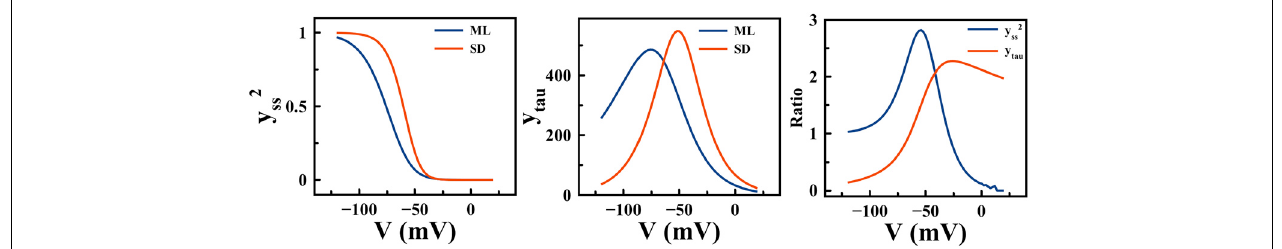
FIGURE 8 | Differences in I f steady state activation ( y 2 ss ) (left) and activation rate constant ( y tau ) (middle) between the ML and SD model. (right) the ratios between SD and ML y 2 ss , and between SD and ML y tau .